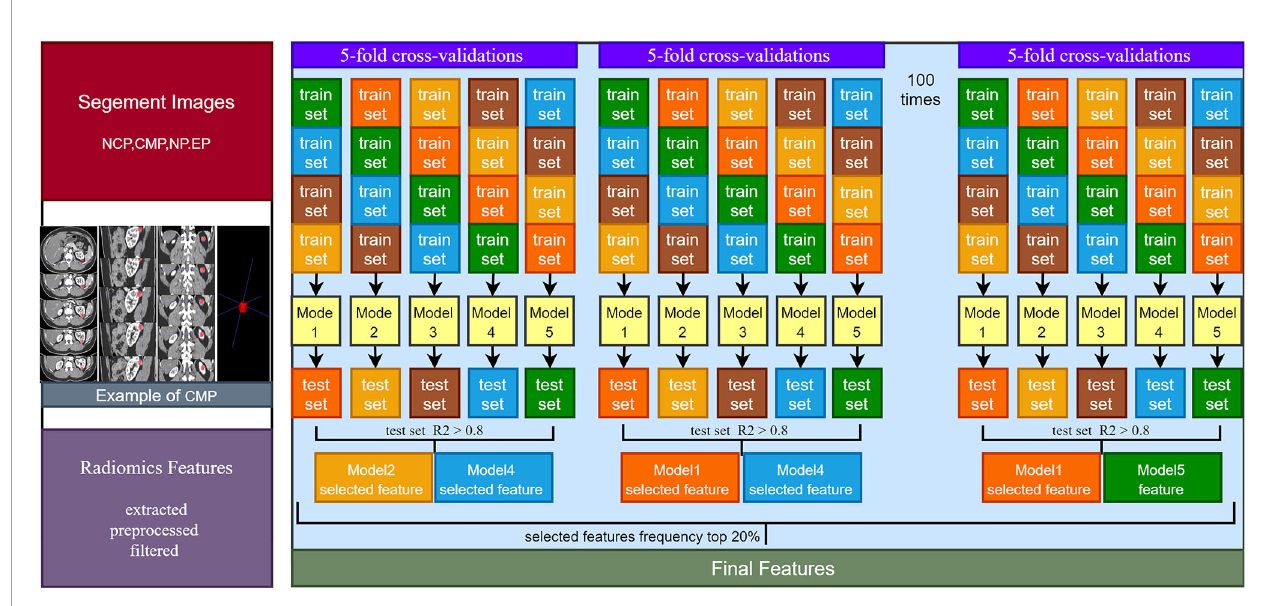
FIGURE 1 | Image segmentation and feature extraction, selection schematic